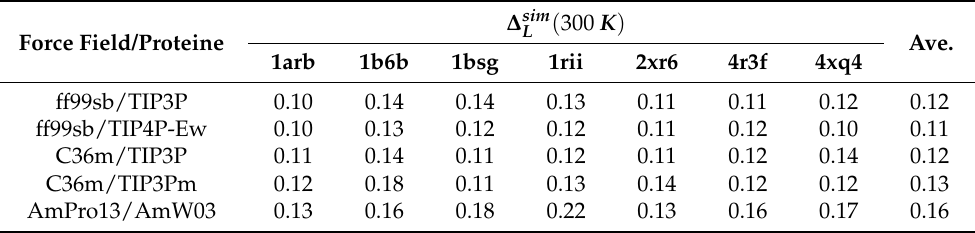
Table 1. Lindemann values for 7 folded proteins at 300 K. A value of α = 4.375Å and <RMSF> averaged over all residues (Figure 3, Supplementary Table S2) were used to calculate ∆ sim L ( 300 K )